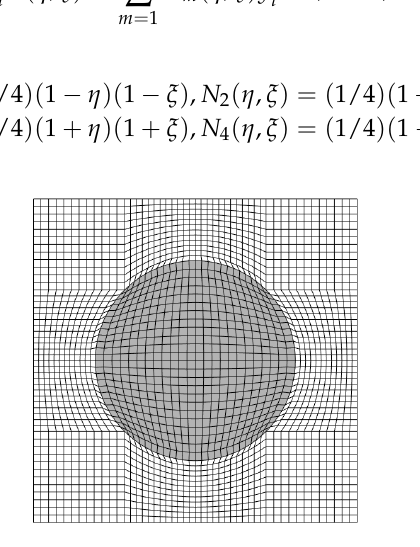
Figure 1. Unit cell